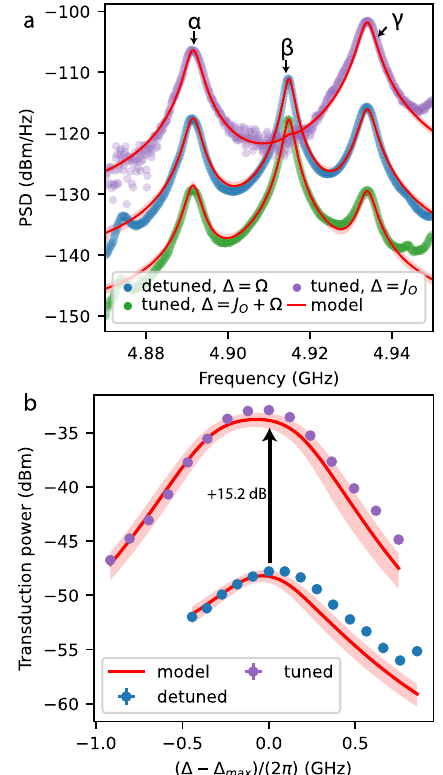
Fig. 4 | Enhanced linear transduction in coupled-mode devices. a Photocurrent power spectral density (PSD) per μ W input power for detuned and tuned devices for several interesting laser-cavity detunings Δ around the optimum value Δ max , showing enhancement of transduction for tuned devices. Red curve shows the model scaled only to the blue trace, with the highlighted area displaying possible variation due to parameter uncertainty. Input powers used: 36 μ W (blue), 68 μ W (green), 109nW (purple), exact values of Re ð Δ max Þ = ð 2 π Þ : 5.00 GHz (blue), 7.61 GHz (green), 2.45 GHz (purple). b The fi tted area of mode γ for detuned and tuned cavities, varying Δ around the optimum value. Vertical error bars are standard deviations in the area due to fi t uncertainty and input power uncertainty.